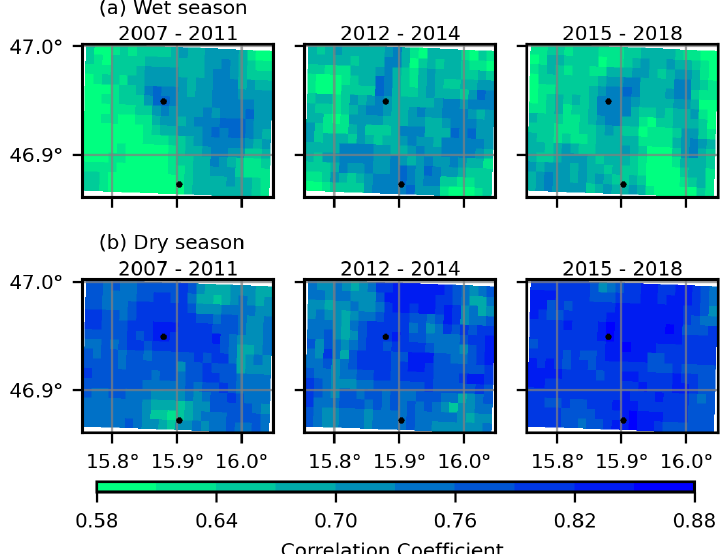
Figure B6. Correlation coefficient between INCA and WegenerNet for 2007–2011 (left), 2012–2014 (center), and 2015–2018 (right) in wet (a) and dry (b) seasons. The black circles indicate the two ZAMG stations in the study